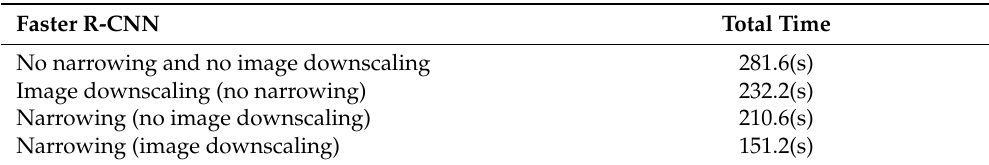
Figure 13. Ship target detection interface.